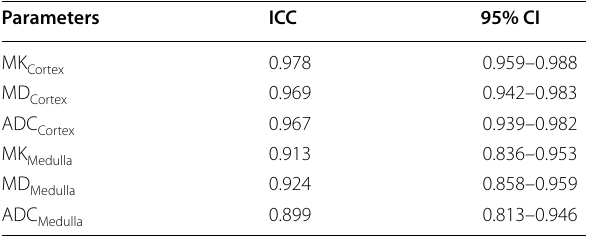
MK, mean kurtosis; MD, mean diffusivity; ADC, apparent diffusion coefficient; ICC, intraclass correlation coefficient; CI, confidence